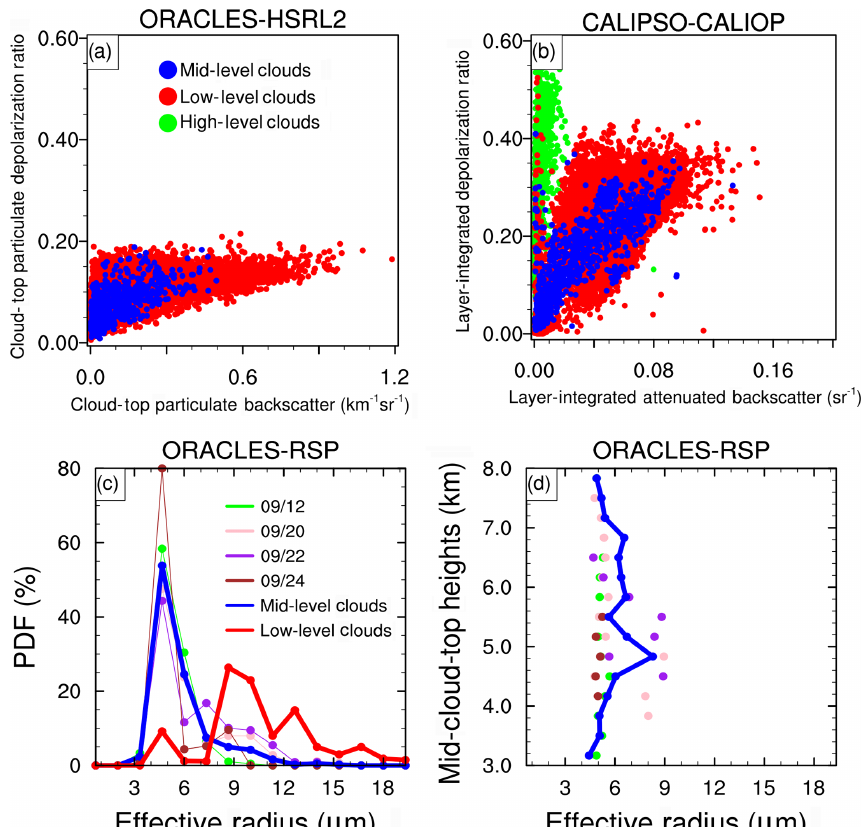
Figure 6. Identifying the phase of southeast Atlantic mid-level clouds. (a) The relationship between the particulate depolarization ratio and the particulate backscatter (km − 1 sr − 1 ) at the cloud top obtained from HSRL-2 during ORACLES-2016, and (b) the volume depolarization ratio and the attenuated backscatter (sr − 1 ) integrated over the cloud layer obtained from CALIOP on board CALIPSO. Both figures are estimated using available data from September 2016 and over the ORACLES-2016 campaign region (inset in Fig. 2b). The low-level clouds (red dots) and high-level clouds (green dots) are respectively the observed clouds with cloud tops less than 3km and greater than 8k˙m, while the mid-level clouds (blue dots) are the observed clouds with cloud tops between 3 and 8km. (c) The probability distribution (PDF; %) of RSP-derived cloud effective radius (µm) for mid-level clouds (solid blue line) and the underlying low-level clouds (solid red line) obtained during ORACLES-2016. (d) The mid-level-cloud effective radius (µm) as a function of the mid-level cloud-top heights (km). The solid blue line in (d) indicates the median effective radius for each height level. The colored dots (in c and d ) and thin lines (in c ) are for individual days when reliable observations were